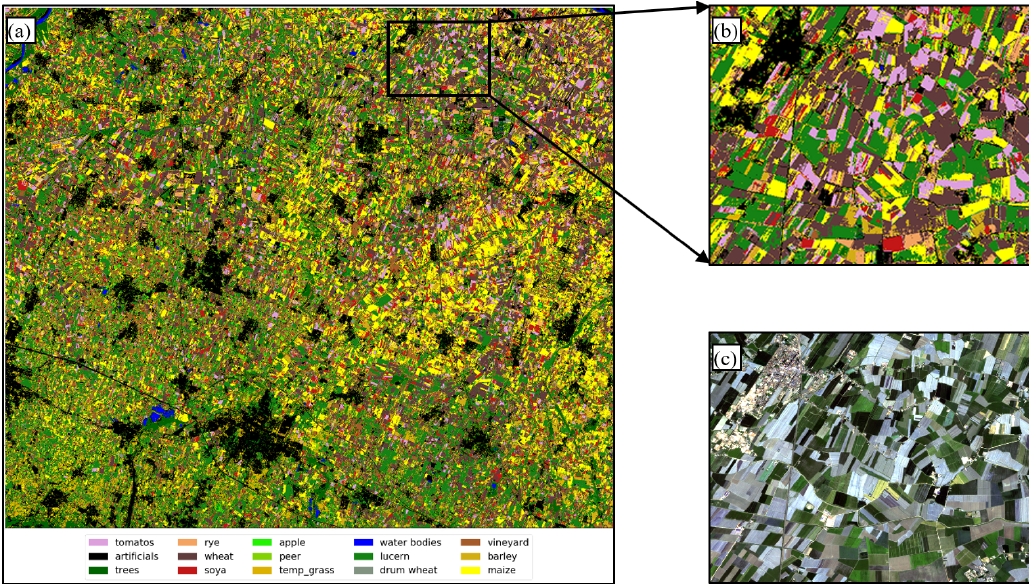
Figure 11. ( a ) Final classified map using Pixel R-CNN, ( b ) zoomed in region of the classified map, and ( c ) Raw Sentinel-2 RGB composite of the zoomed